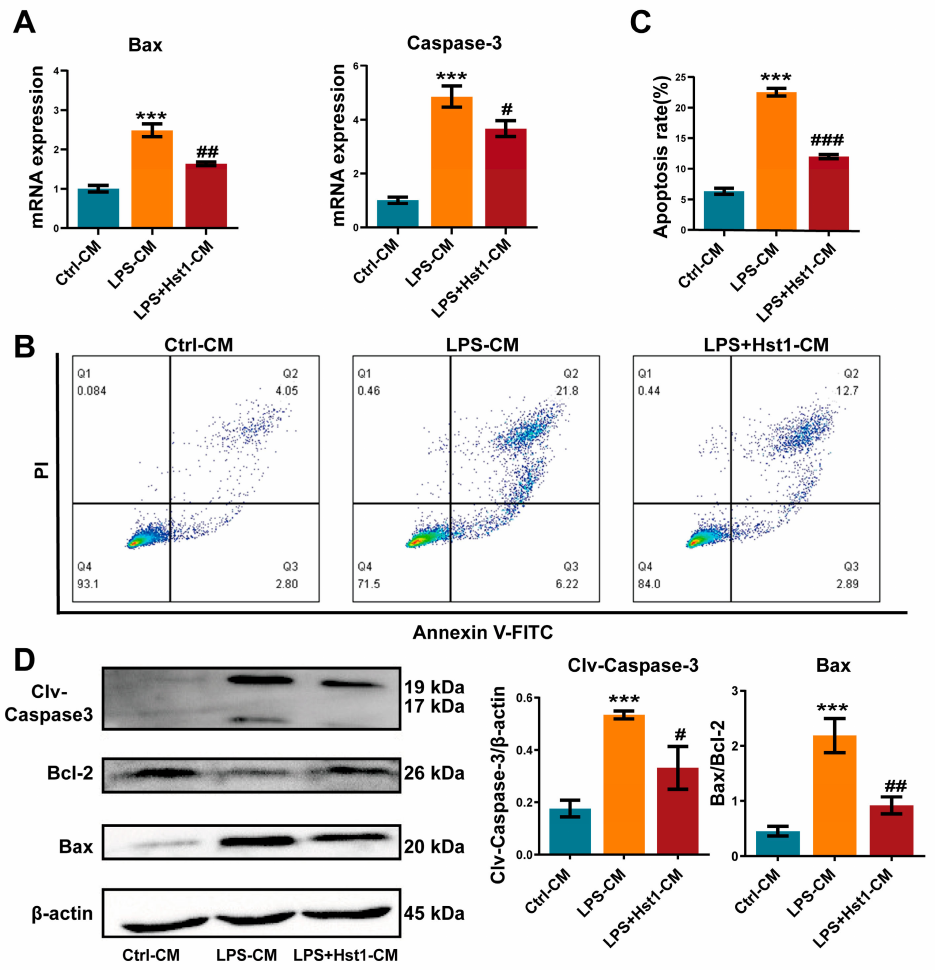
Figure 10. CM from Hst1-treated macrophages reduced ATDC5 cell apoptosis. ( A ) RT-qPCR analysis for apoptosis-related genes Bax and caspase-3. ( B-C ) The apoptosis rate of ATDC5 cells was analyzed using flow cytometry with annexin V-FITC/PI apoptosis analysis. ( D ) Western blot analysis and quantification of apoptosis-related proteins Bax, Bcl-2, and cleaved caspase-3. ATDC5 cells were cultured with macrophage CM for 7 days. Blots are cropped from Supplementary File S4. Data are expressed as means ± SD from three independent experiments. Significant differences compared to control-CM group: *** p < 0.001, and compared to LPS-CM group: # p < 0.05, ## p < 0.01, and ### p <